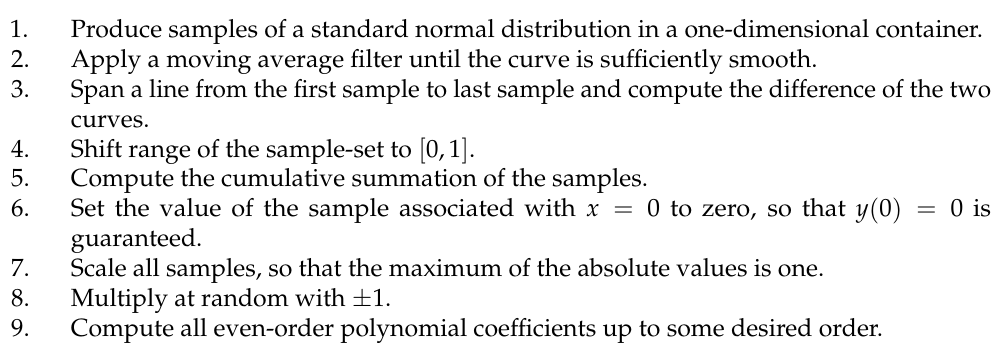
Algorithm 2. Random static nonlinear transfer function